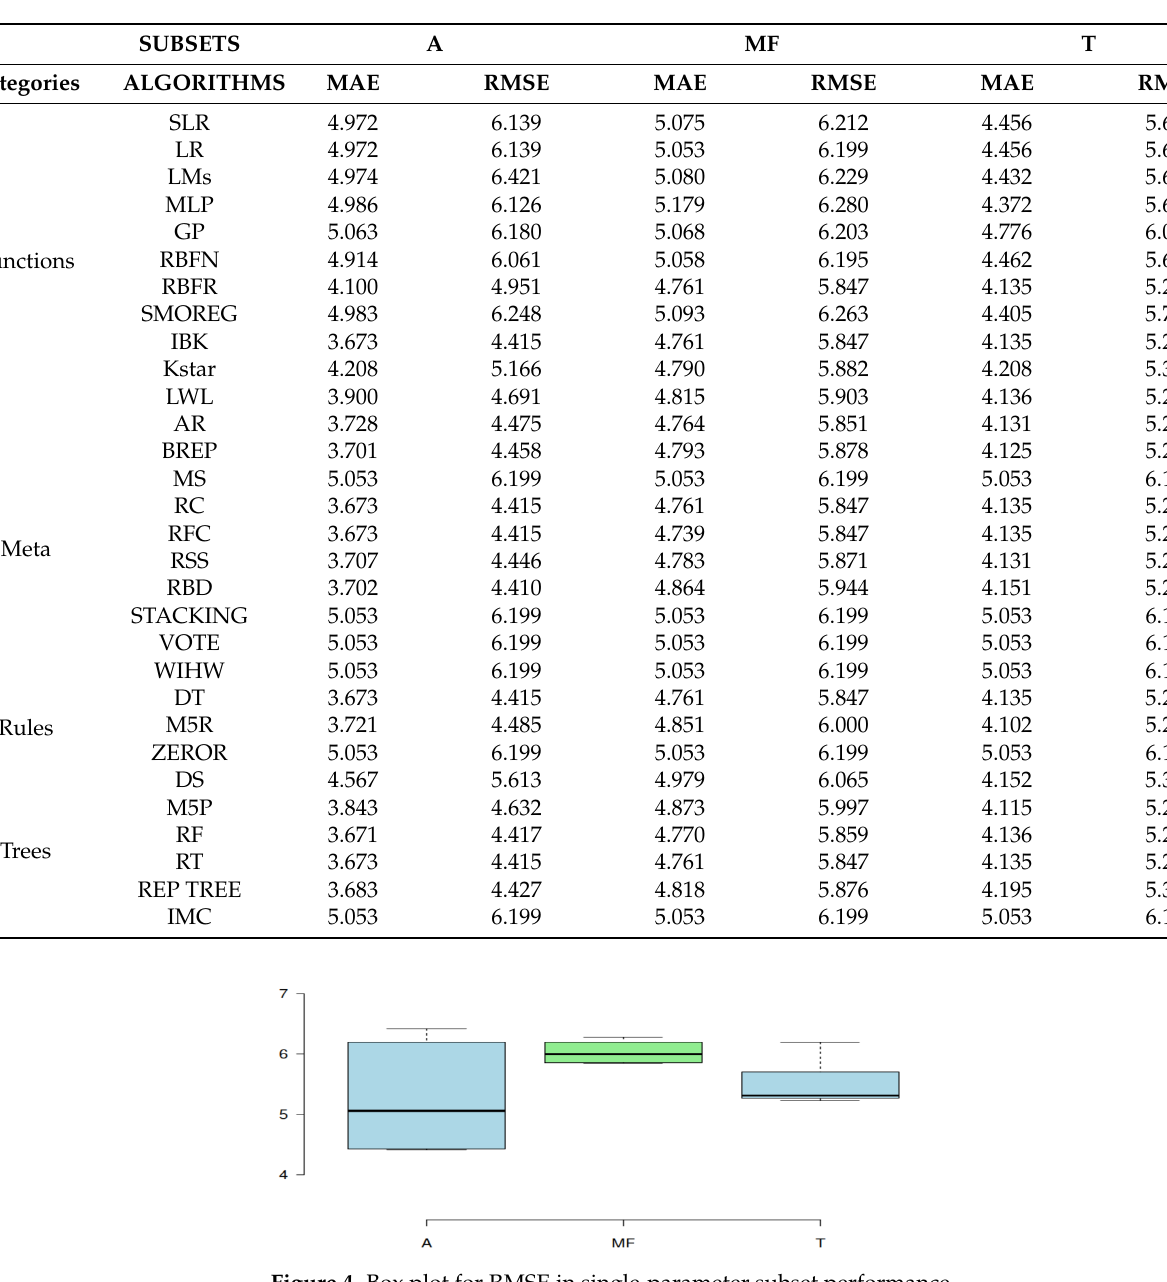
Table 5. Subsets with one parameter—Performance.